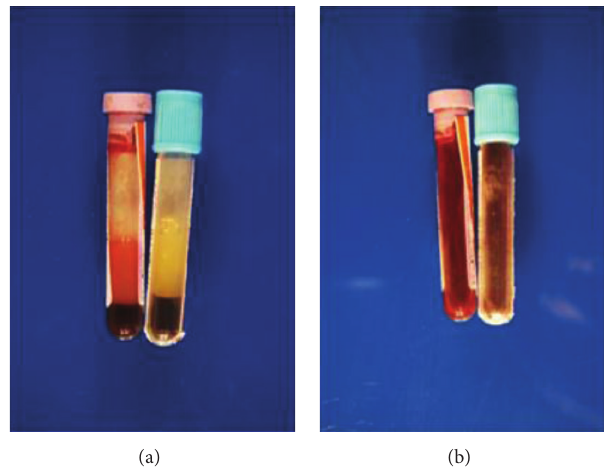
Figure 2: (a) EDTA and Na citrate specimens clotting at room temperature. (b) Blood specimen warmed to 37 ∘